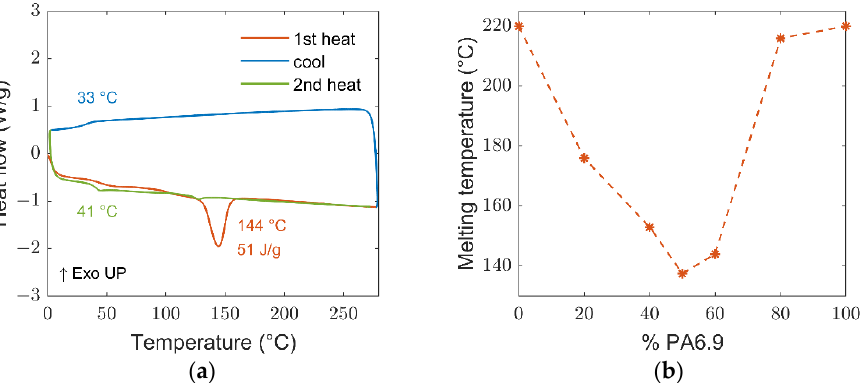
Figure 3. DSC curves of PA6.9-6 60-40 with indication of melting and glass transition temperatures ( a ), melting temperatures for different monomers ratio ( b ).